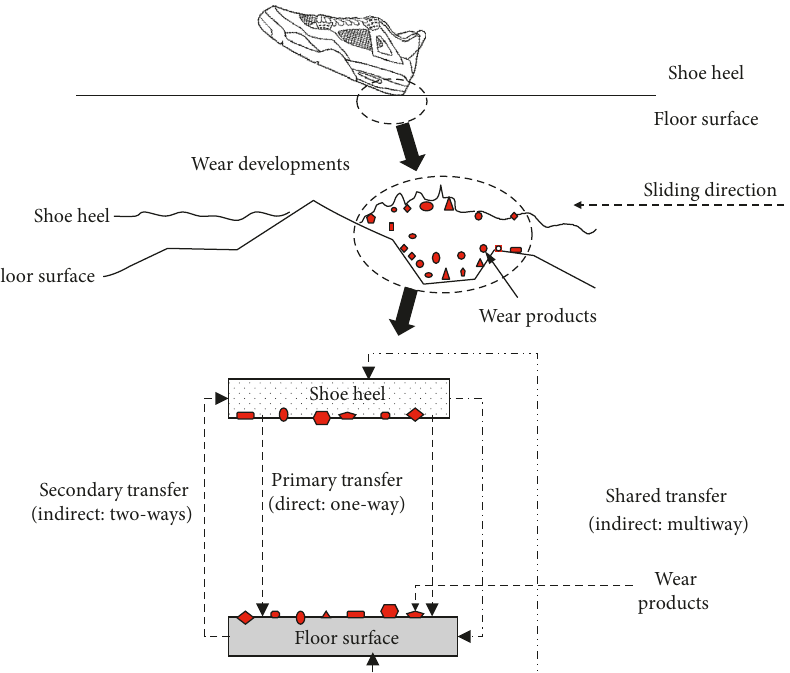
Figure 7: A flooring wear model suggests three probable wear mechanisms: primary (one-way), secondary (two-ways), and shared (multi- ways) wear